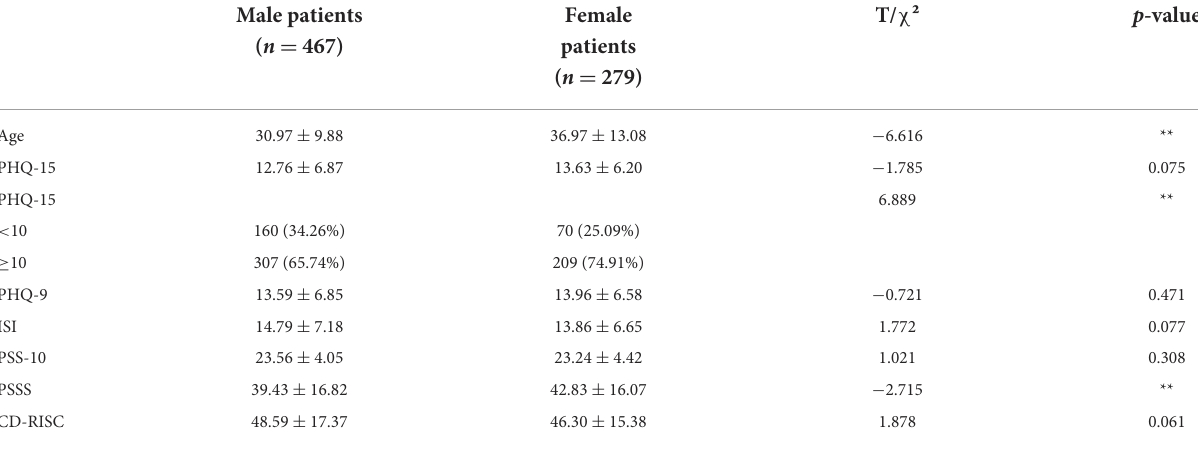
TABLE 2 Comparison of different